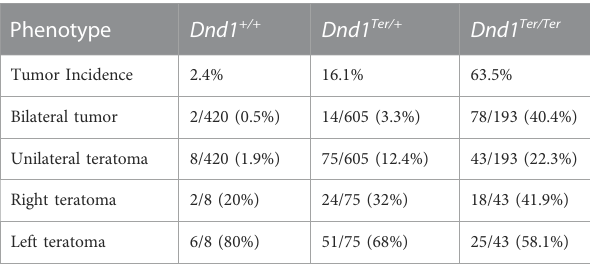
TABLE 1 Incidence of testicular teratoma in 129 Sv/J Dnd1 Ter mice.